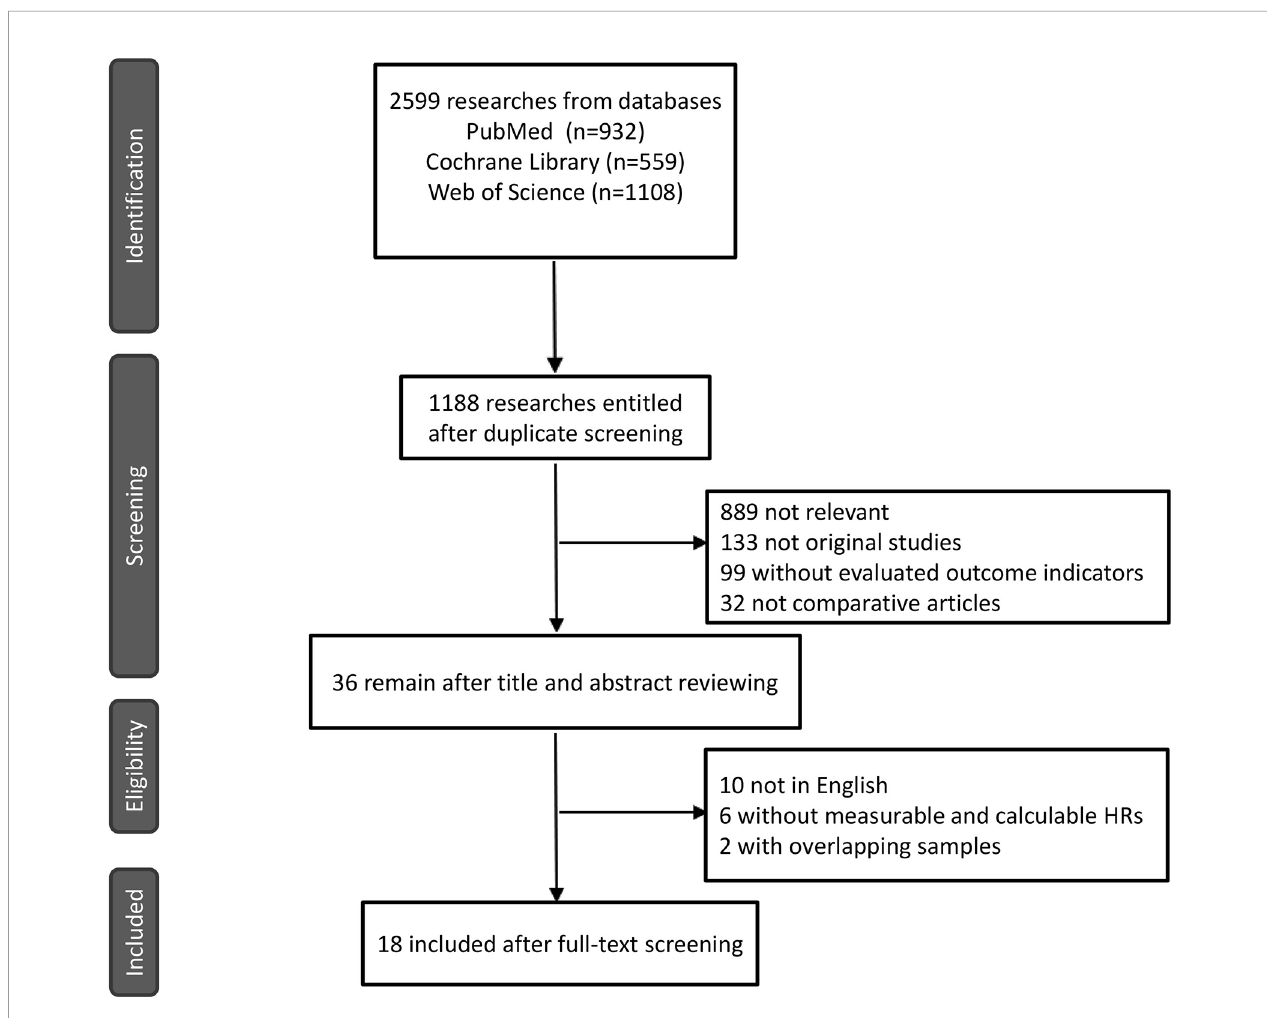
FIGURE 1 | Flow chart of work